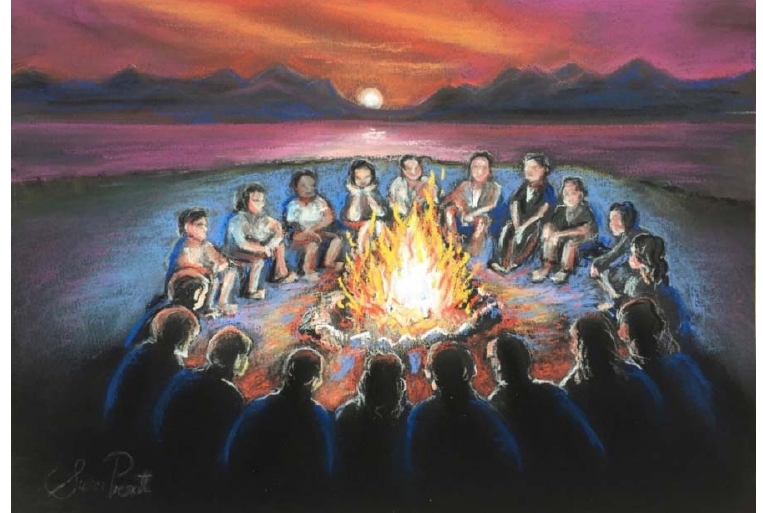
Figure 1. The Canmore Declaration: for personal and planetary health in every community—promoting the interdependent vitality in all natural and anthropogenic ecosystems. Improving the health of all systems depends on: mutualistic values; planetary consciousness; advocacy; unity of purpose; recognition of biopsychosocial interdependence; emotional bonds between people and the land; efforts to counter elitism, social dominance and marginalization; meaningful cross-sectoral and cross-cultural narrative; self-awareness; and a personal commitment to shaping new normative attitudes and behaviors.